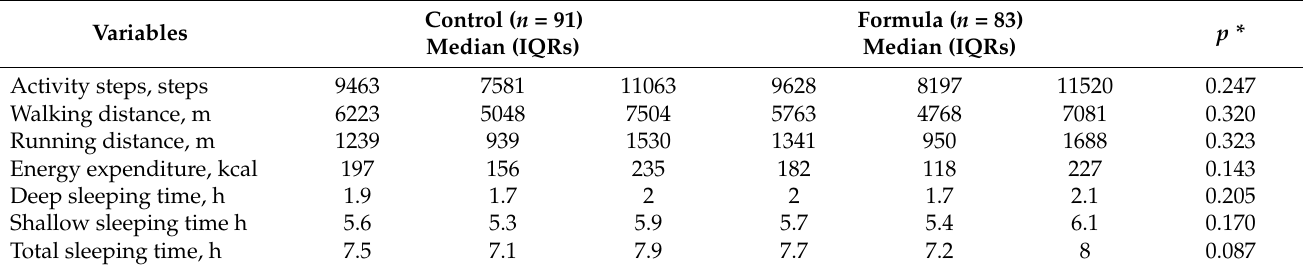
Table 4. Comparison of daily physical activity and sleeping time in the formula and control groups during the intervention